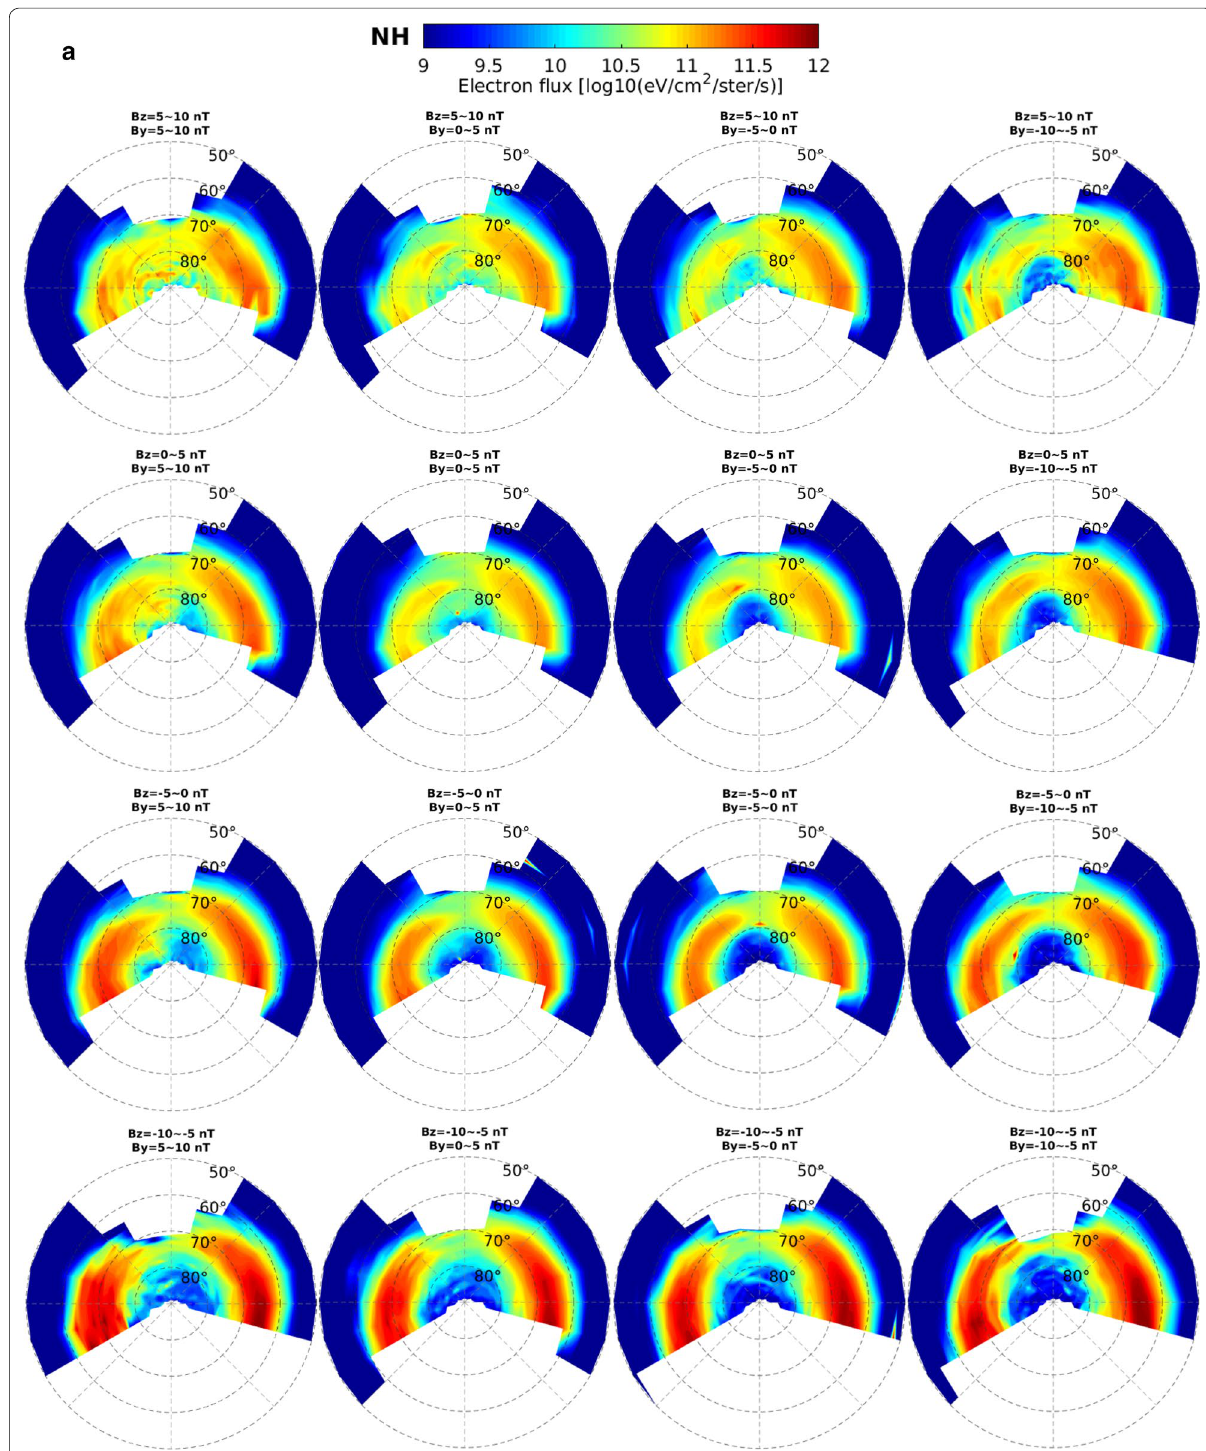
Fig. 5 a The MLAT versus MLT distribution of electron energy flux derived from the DMSP satellites for the northern hemisphere. b As the same as Fig. 5a, but for the electron energy flux distribution in the southern